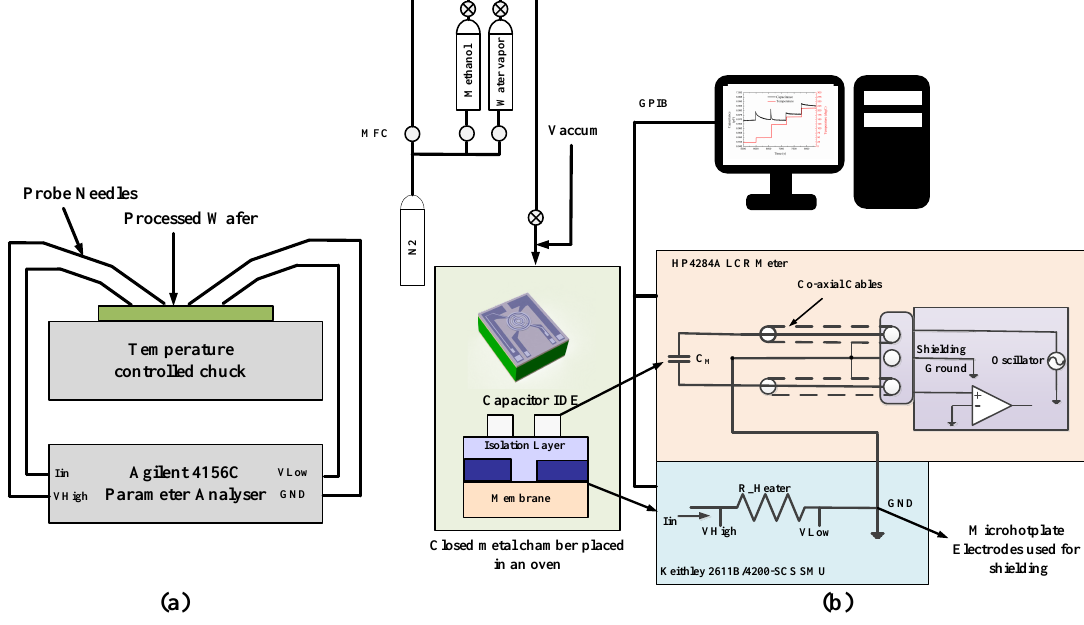
Figure 3. ( a ) Electrical characterization of the microhotplate. ( b ) Schematic representation of the gas sensing measurement setup. MFC: Mass Flow controller; GPIB: General Purpose Interface Bus; GND: